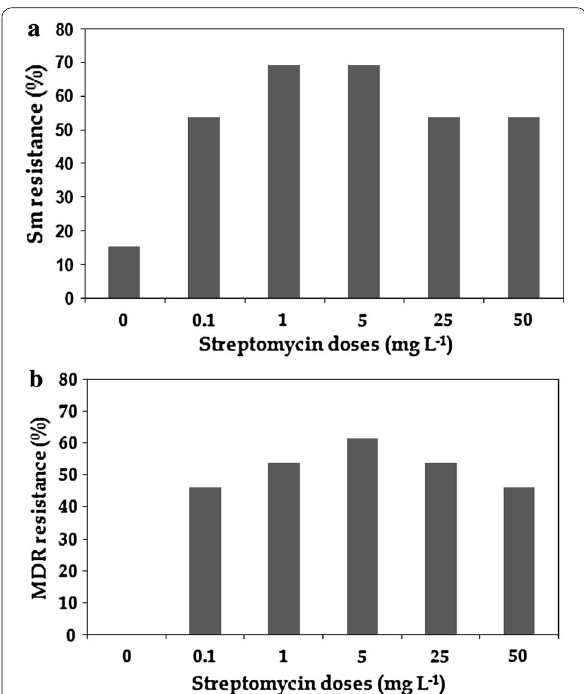
Fig. 3 MIC assay showing the prevalence of bacterial streptomycin resistance ( a ) and MDR ( b ) in the various streptomycin exposures. A total of 78 dominant bacterial isolates (13 isolates from each expo‑ sure) and nine antibiotics were used for the MIC assay. The number of resistant strains among the total strains was taken for the calculation of resistance prevalence